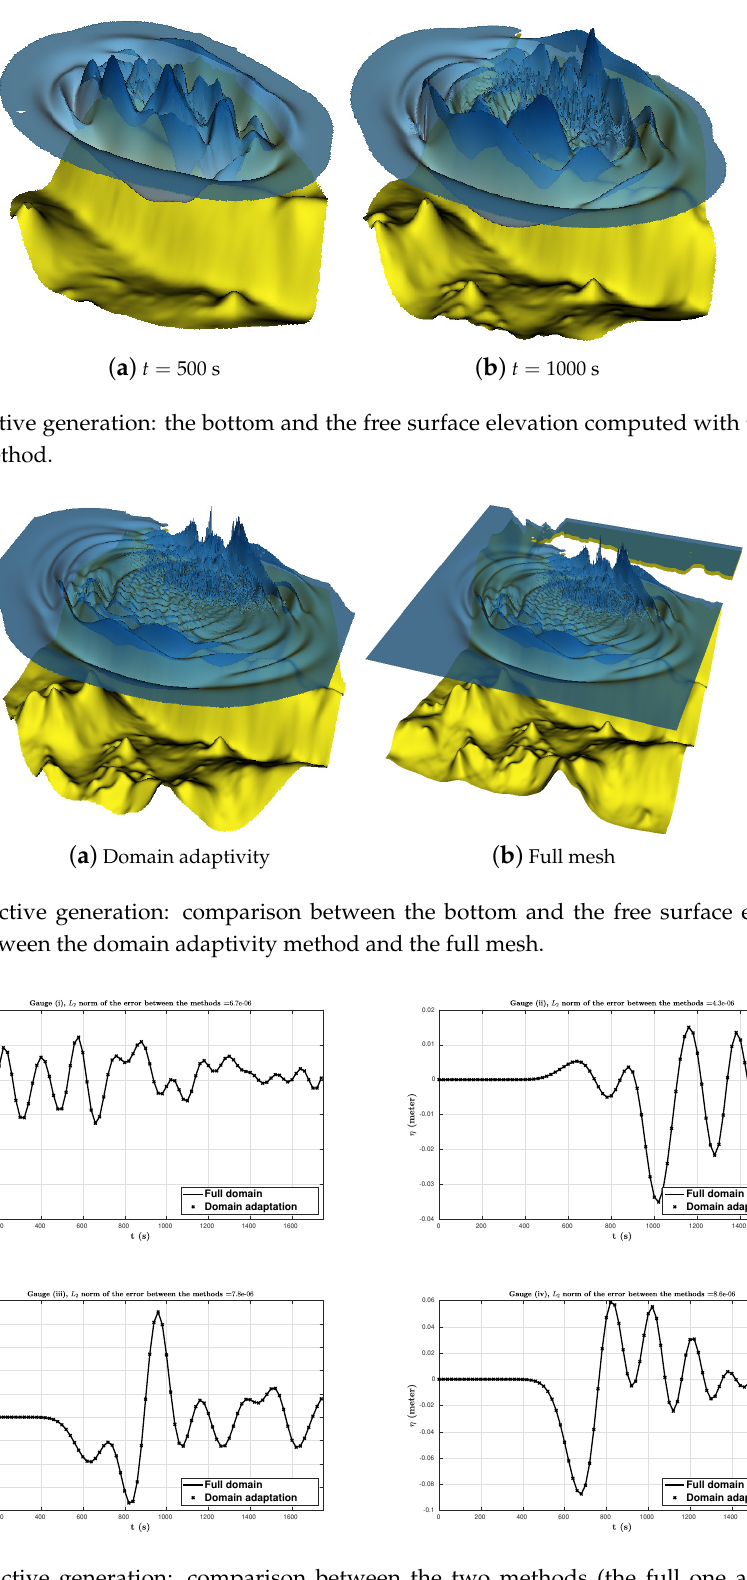
Figure 22. Active generation: comparison between the two methods (the full one and domain adaptivity) of the free surface elevations (in meters) vs. time (in seconds), computed numerically at four wave gauges where the gauge (i) correspond to the